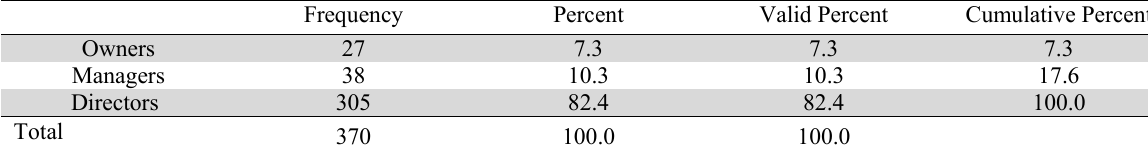
Position of respondent